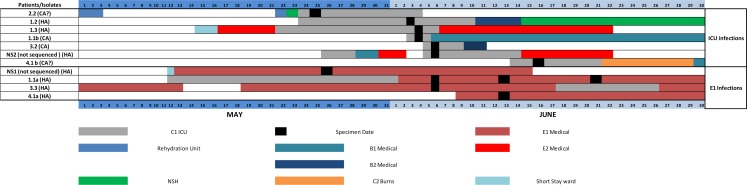
Timeline displaying patient admission, movement and Influenza A (H1N1pdm) positivity within hospital (patient/isolate identity according to ML Cluster identity).